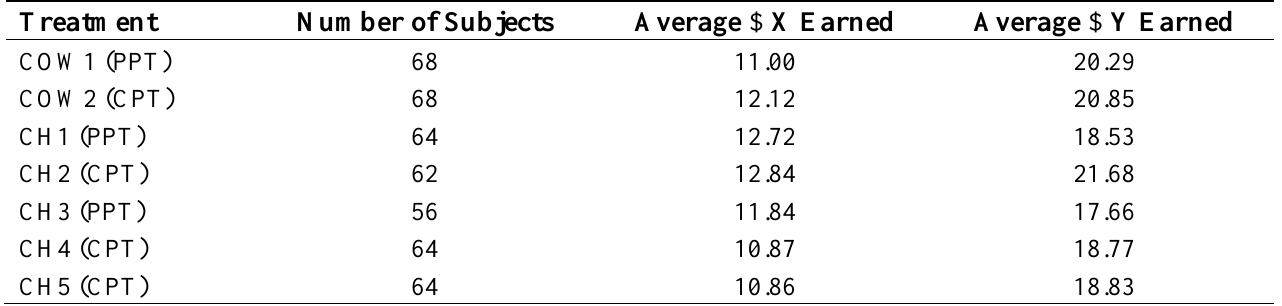
Table 1. Summary of treatments, sample sizes, and subjects’